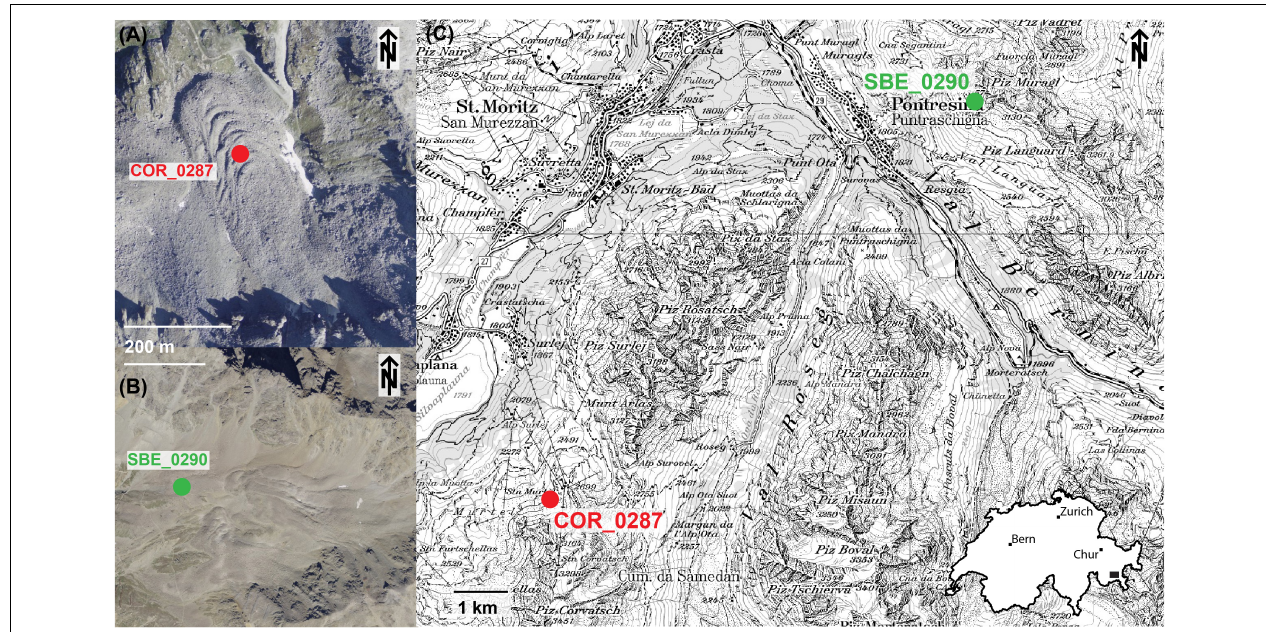
FIGURE 1 | Aerial images of the Corvatsch – Murtel (A) and the Schafberg (B) rock glacier with the location of the PERMOS boreholes, situated in the Upper Engadin valley, Eastern Swiss Alps (C) . Source: Swiss Federal Office of Topography swisstopo.